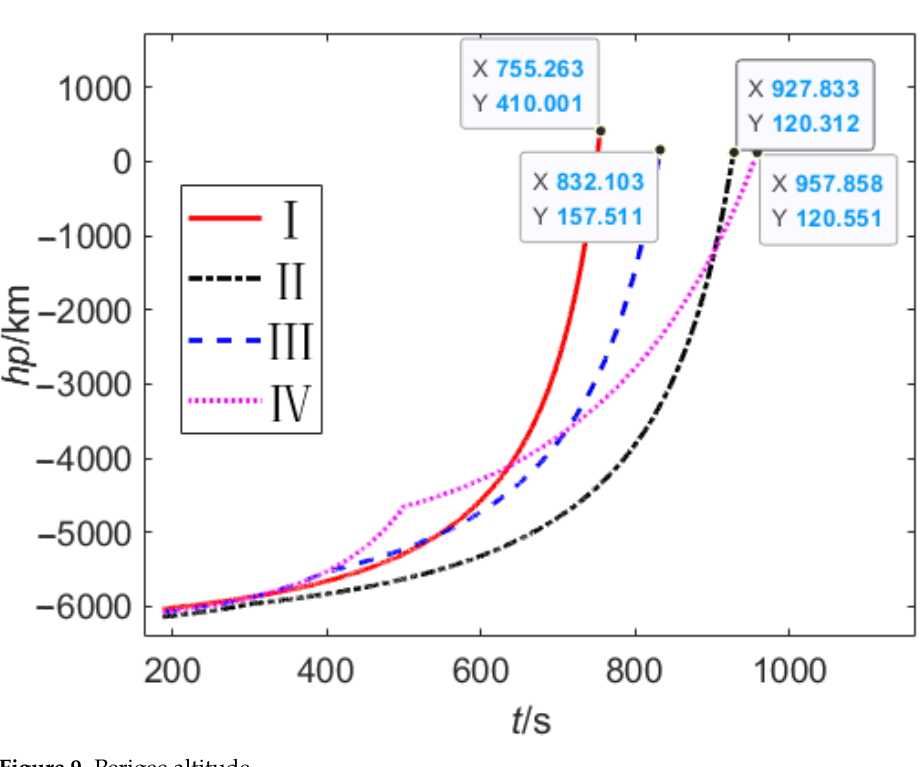
Figure 8. Flight trajectory and terminal orbit.